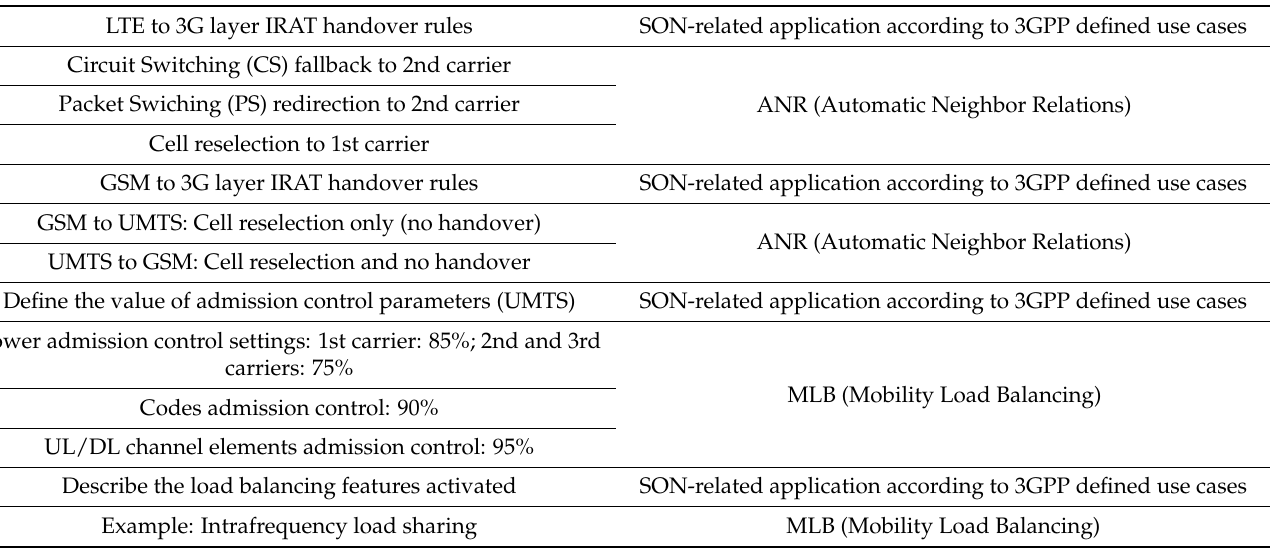
Table 1. Correlation of basic radio access parameters with SON